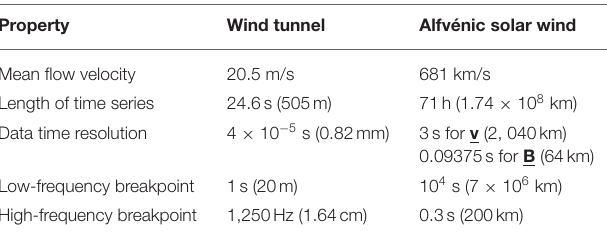
TABLE 1 | Some properties of the wind-tunnel and Alfvénic solar-wind time series analyzed in this study.